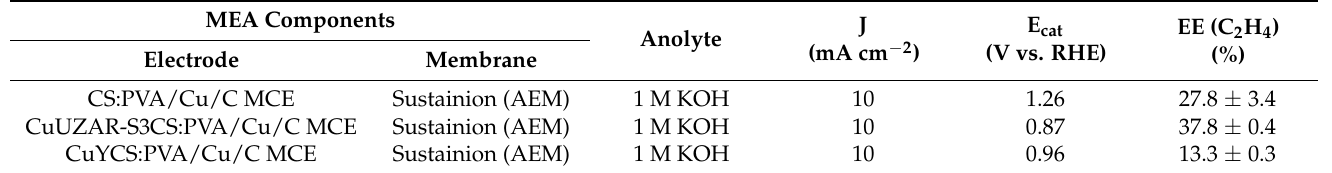
Table 3. Experimental results of the CO 2 R conversion to C 2 H 4 in MEA configuration with Cu-based membrane coated electrodes (MCEs) in 1 M KOH.